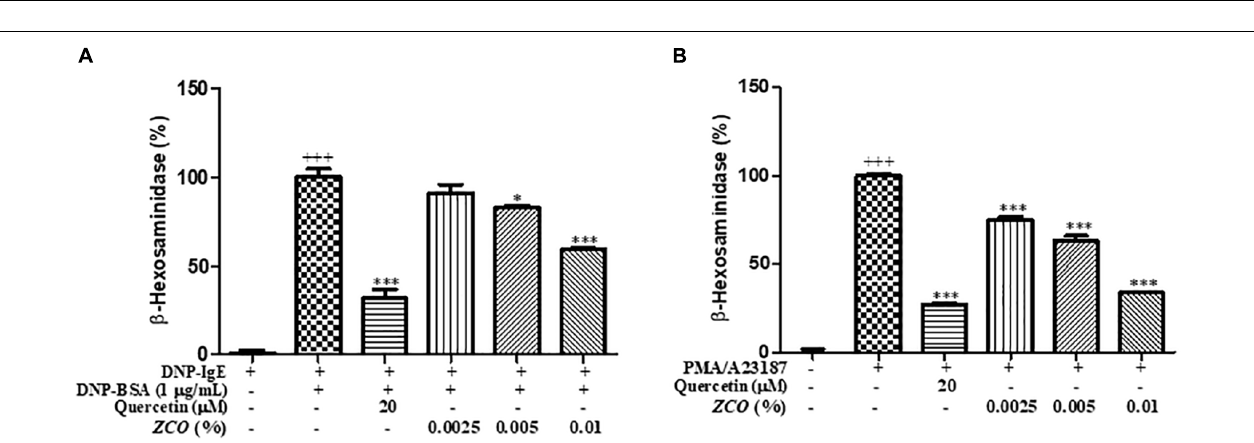
FIGURE 1 | Effect of ZCO on the cell viability. (A) RBL-2H3 cells, (B) RAW264.7 cells, and (C) 293T cells were seeded into 96-well plate overnight, and then were treated with ZCO (0.0025, 0.005, and 0.01%) for 24 h. The cell viability was tested by MTS assays. The data are representative of three independent experiments and expressed as mean ± SEM ( ∗ P < 0.05; ∗∗∗ P < 0.001 versus with control group).